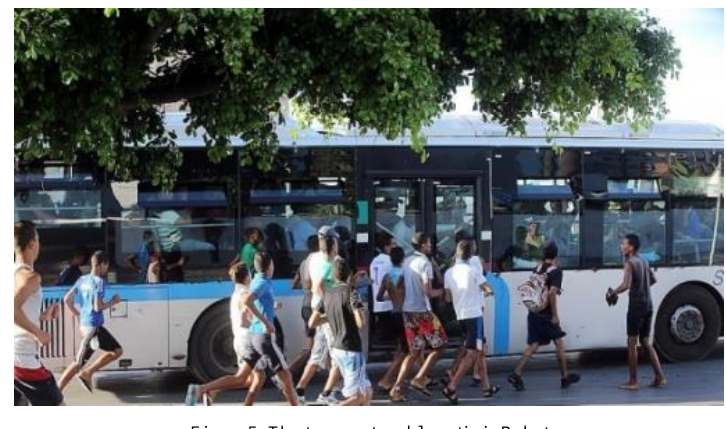
Figure 5: The transport problematic in Rabat